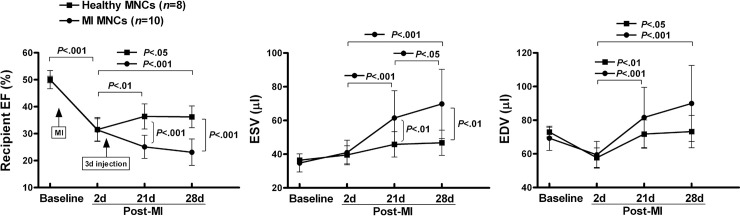
Reproducibility of TIME MNC therapeutic impairment and comparison of day 21 and 28 function.Therapeutic impairment of the TIME MNCs was also apparent in this earlier (non-blinded) pilot experiment. Moreover, EF was stable between days 21 and 28 post-recipient MI in the healthy donor MNC group, but declined during that period in the TIME MNC group. Error bars = SD.